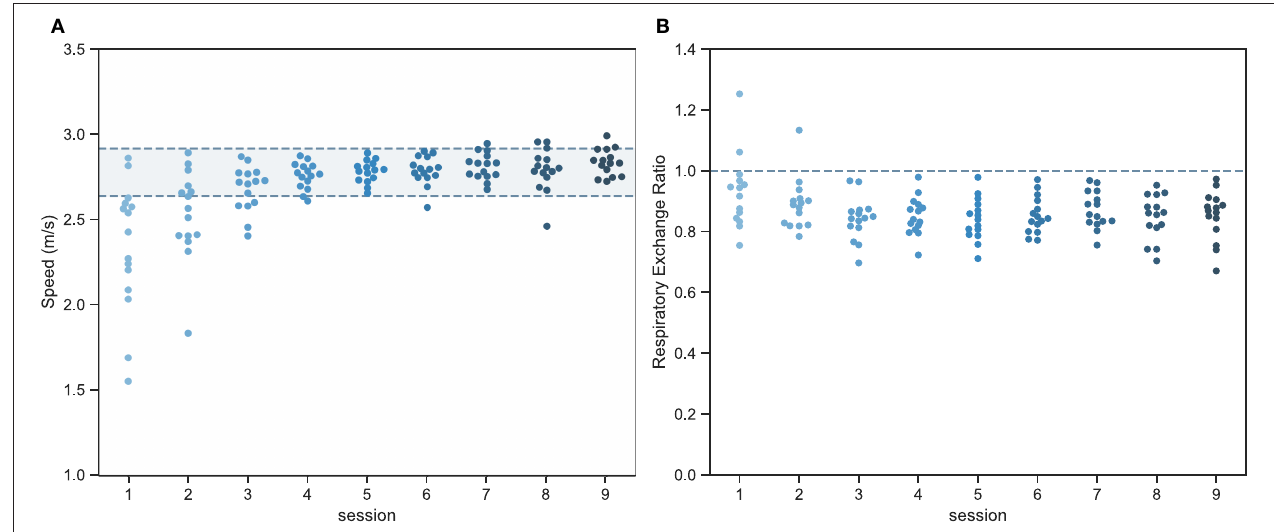
FIGURE 2 | Swarmplot of the ability of individual participants to match the target speed ± 5% (A) and the respiratory exchange ratio (RER) < 1.0 (B) during each session (n=15).